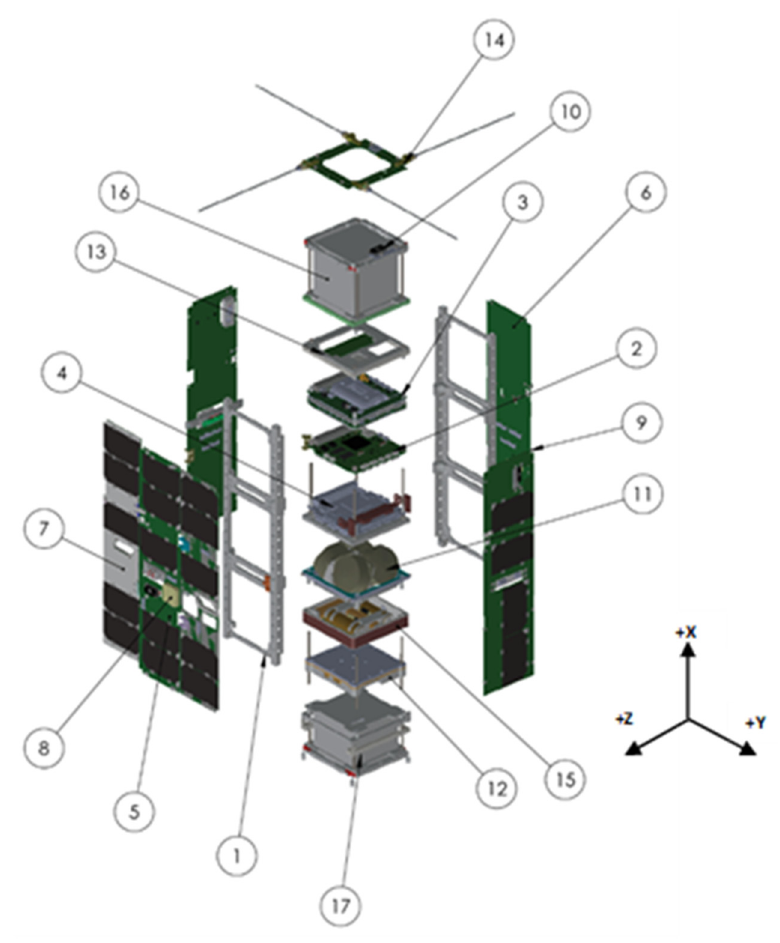
Figure 5. Light-1 assembly.